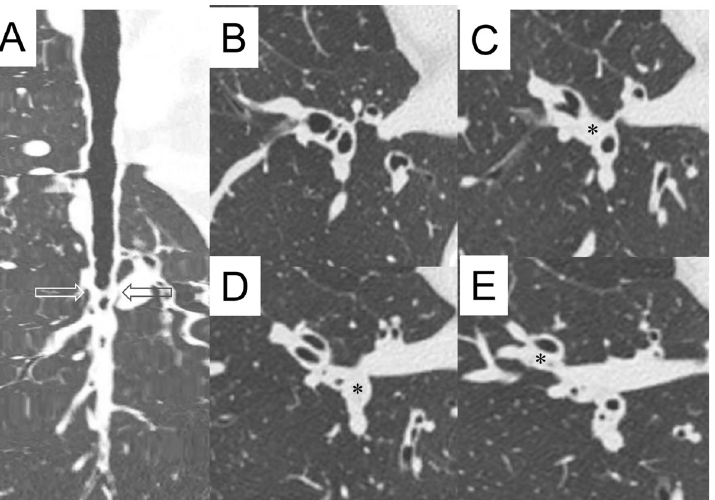
Fig 1. Representative view of mucus plugs. A: Longitudinal view of right B10 bronchus. Peripheral parts of the bronchus (bottom of the panel) are open. B: Conventional HRCT images of right B7, B8, B9, and B10. C: Conventional HRCT image just below the level of panel B. Occluded segmental bronchus (second generation, marked with an asterisk) of right B9 is shown. D: Conventional HRCT image just below the level of panel C (indicated level in panel A by arrows). Occluded segmental bronchus (second generation, marked with an asterisk) of right B10 is shown. E: Conventional HRCT image just below the level of panel D. Occluded subsegmental bronchus (third generation, marked with an asterisk) of right B8 is